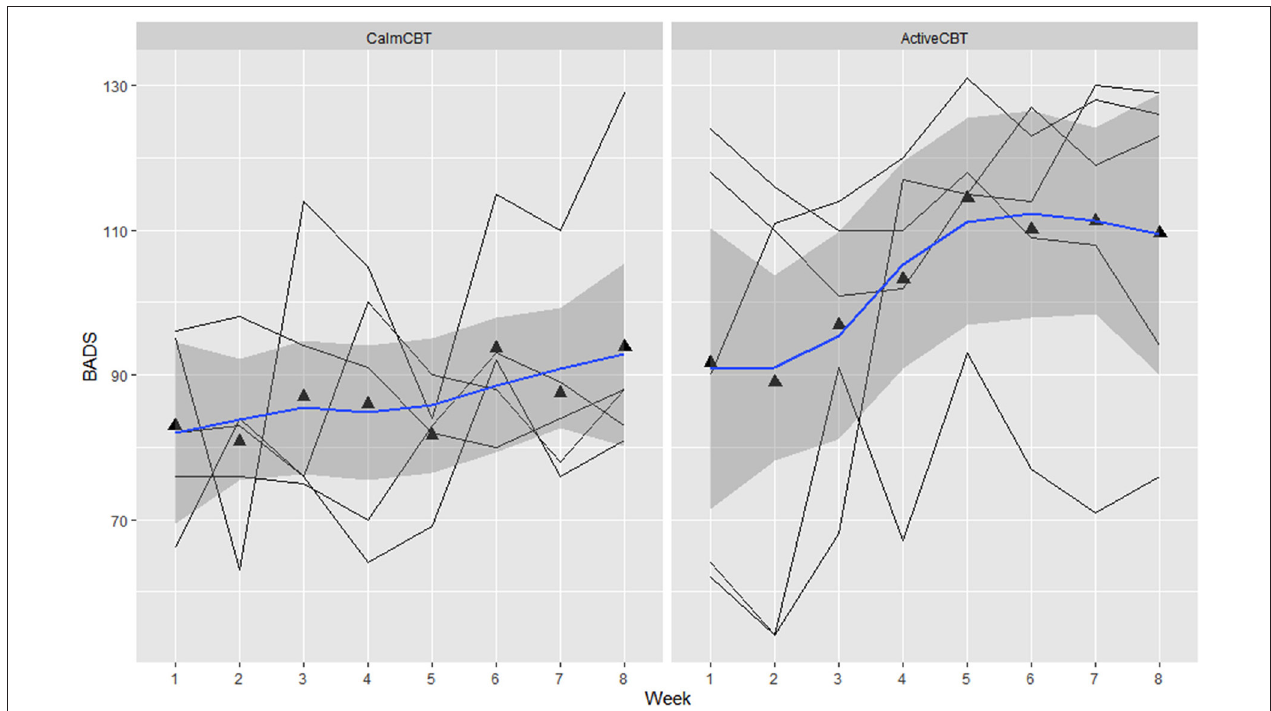
FIGURE 5 | Behavioral activation for depression scale (BADS) by group across time. Data are total scores of the BADS administered at the beginning of each CBT session visit (i.e., before the Active/Calm condition). High scores indicate greater levels of reported behavioral activation.